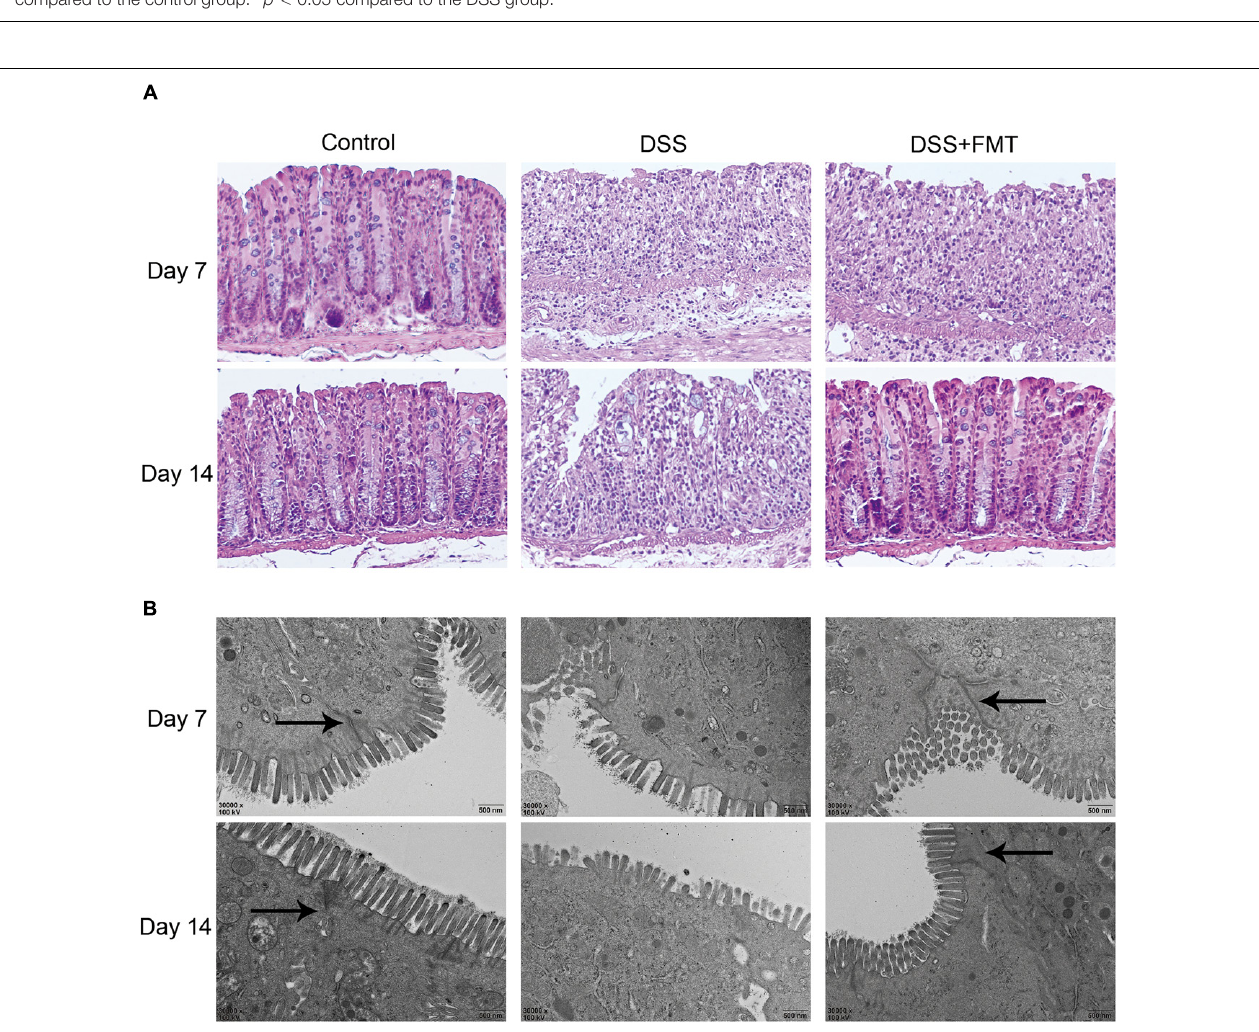
FIGURE 3 | Fecal microbiota transplantation promoted the repair of DSS-induced histological damage to colon tissue. (A) Colon tissue sections were stained with HE. Scale bars = 50 µ m. (B) FMT promoted the repair of microscopic damage in colon tissue induced by DSS. The colon tissue sections of mice in each group was measured by transmission electron microscopy. The arrow represents tight connection. Scale bars = 500 nm. Representative histology from the control, DSS, and DSS+FMT groups.